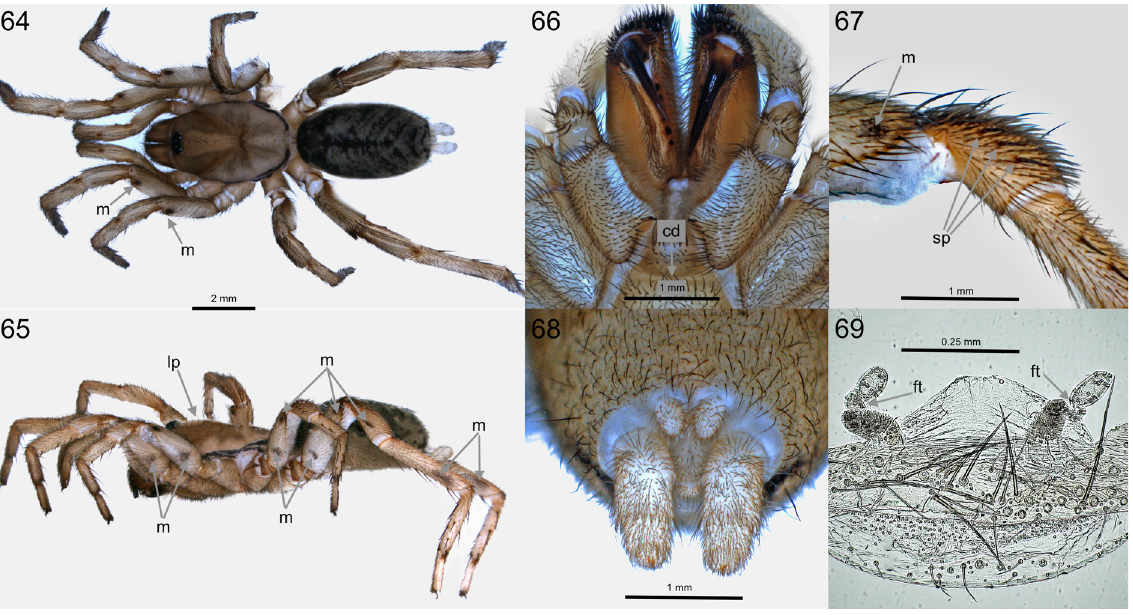
Figs 64–69. Nemesia maltensis sp. nov. paratype, ♀ (TC.012, NHMR). 64 . Dorsal habitus, note maculae on external femora I & II (m). 65 . Left lateral habitus, note numerous maculae on legs arrow indications (m) and the low carapace profile (lp). 66 . Ventral anterior prosoma, note indistinct central division (cd) in labial furrow. 67 . Prolateral patella III, note three spines (sp) in a row. 68 . Ventral spinnerets, note absence of distinct light coloured spigot fields. 69 . Spermathecae, ventral view, note median part of the receptacles being folded and twisted